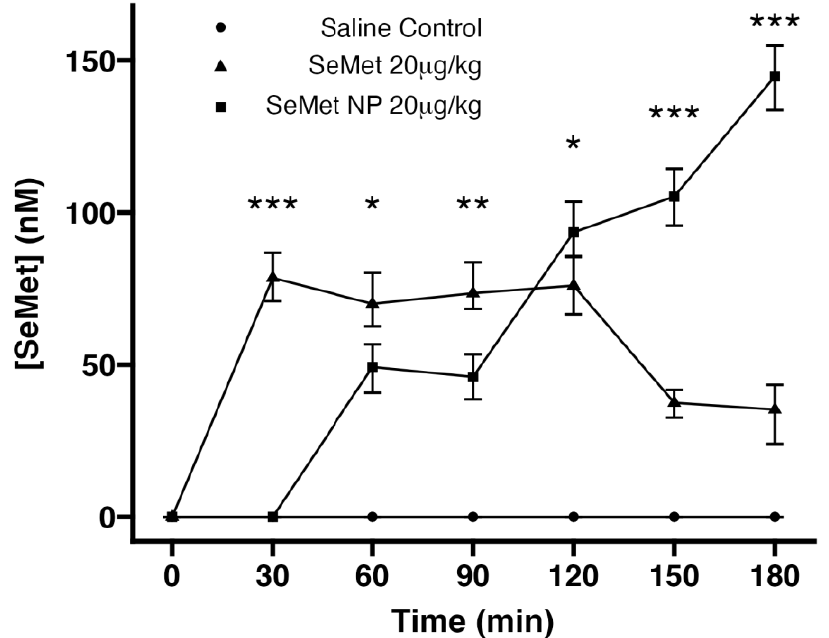
Figure 6. Measurement of plasma SeMet concentration following jejunal instillation of SeMet, SeMet-NPs and saline. Bonferroni test *** p < 0.001, ** p < 0.01, * p < 0.05, SeMet NPs compared to SeMet. Each value represents the mean ± SEM, n = 5 independent experiments.